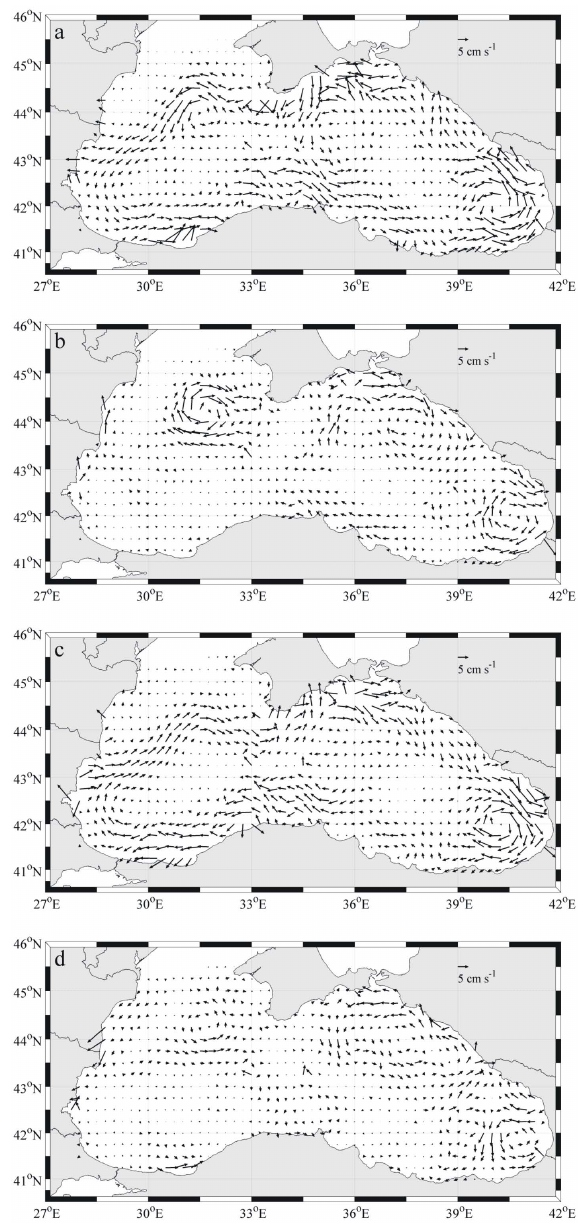
Fig. 2. Unbiased estimates of the anomalies of the mean surface geostrophic circulation in the Black Sea during (a) winter (January– March), (b) spring (April–June), (c) summer (July–September), (d) fall (October–December), in spatial bins of 0.25 ◦ × 0.25 ◦ and for the period